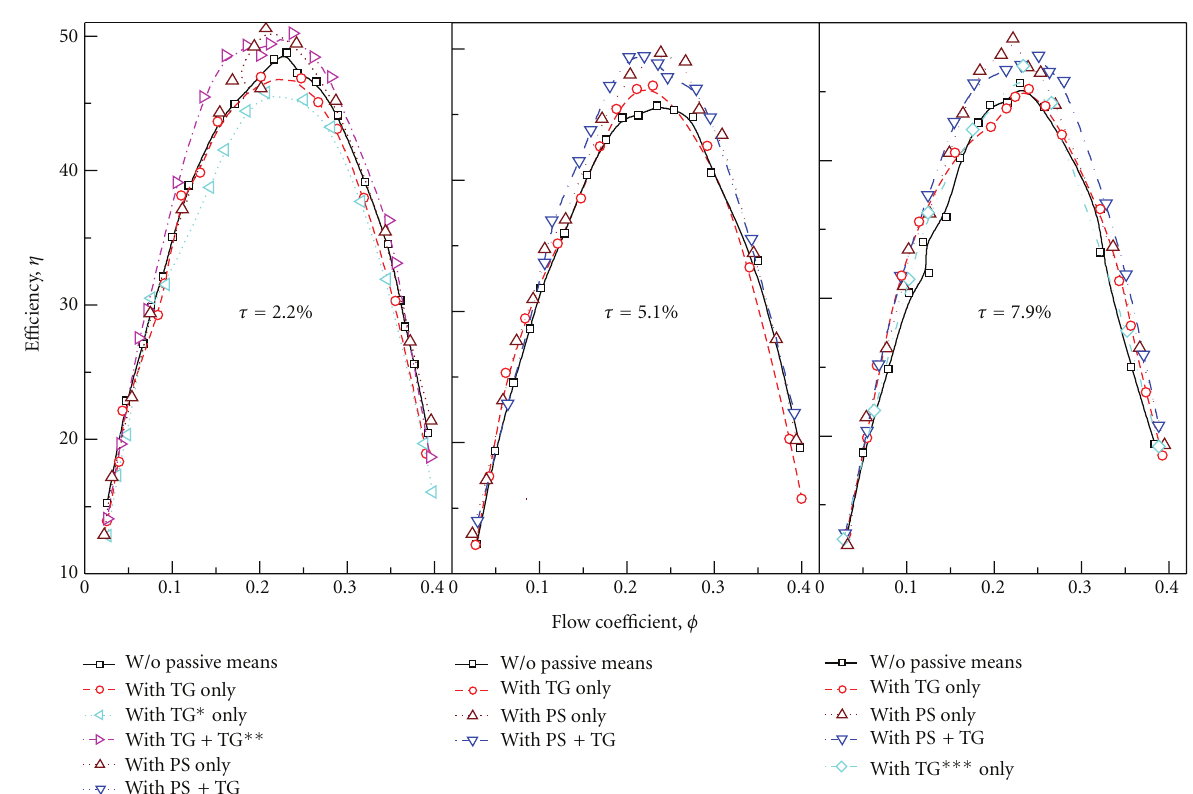
Figure 4: Performance characteristics of the centrifugal compressor ( η versus φ ): e ff ect of configuration.